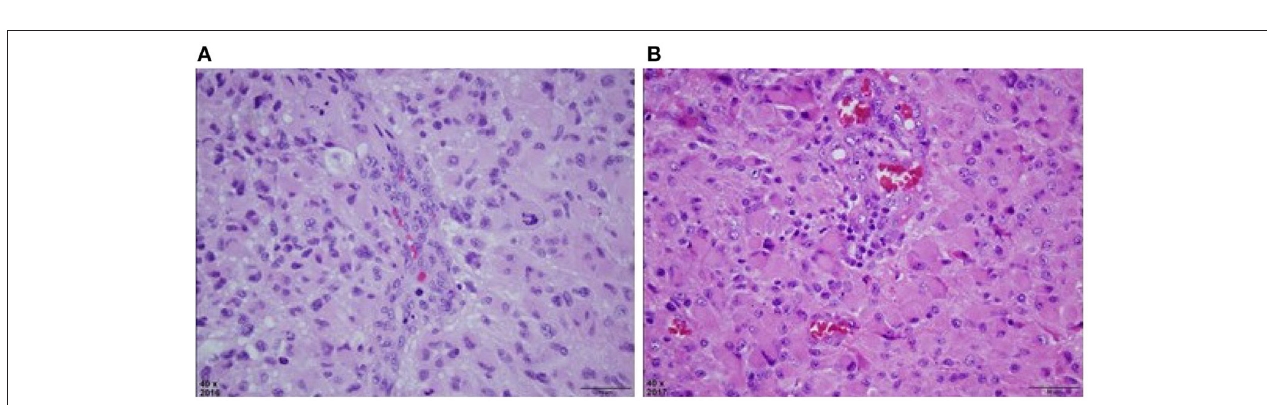
FIGURE 2 | (A) H&E stained section of right parietal tumor at original magnification of 40x, reveals a densely cellular astrocytic neoplasm with nuclear atypia, mitosis, and vascular endothelial proliferation. Palisaded necrosis was also present but not shown in this field. (B) H&E stained section of right temporal mass at original magnification of 40x, also reveals a densely cellular astrocytic neoplasm with slightly more gemistocytic features, nuclear atypia, mitosis, and vascular endothelial proliferation that was similar to the previously resected tumor. This material lacked